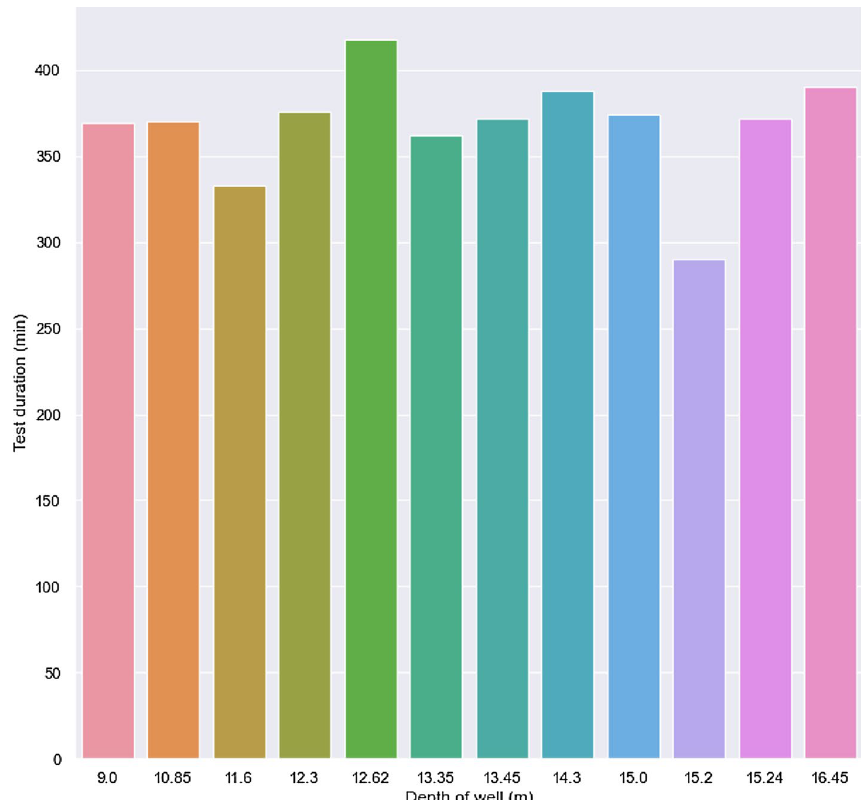
Fig. 3 Depth of well versus pumping test duration of